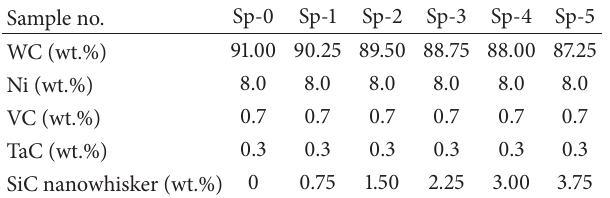
Table 2: Nominal compositions of the designed samples in this